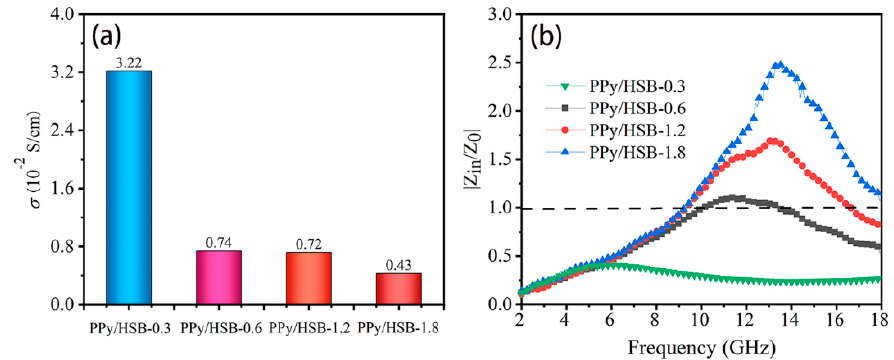
Figure 9. Electrical conductivity ( a ) and impedance matching ( b ) of PPy/HSB composites.